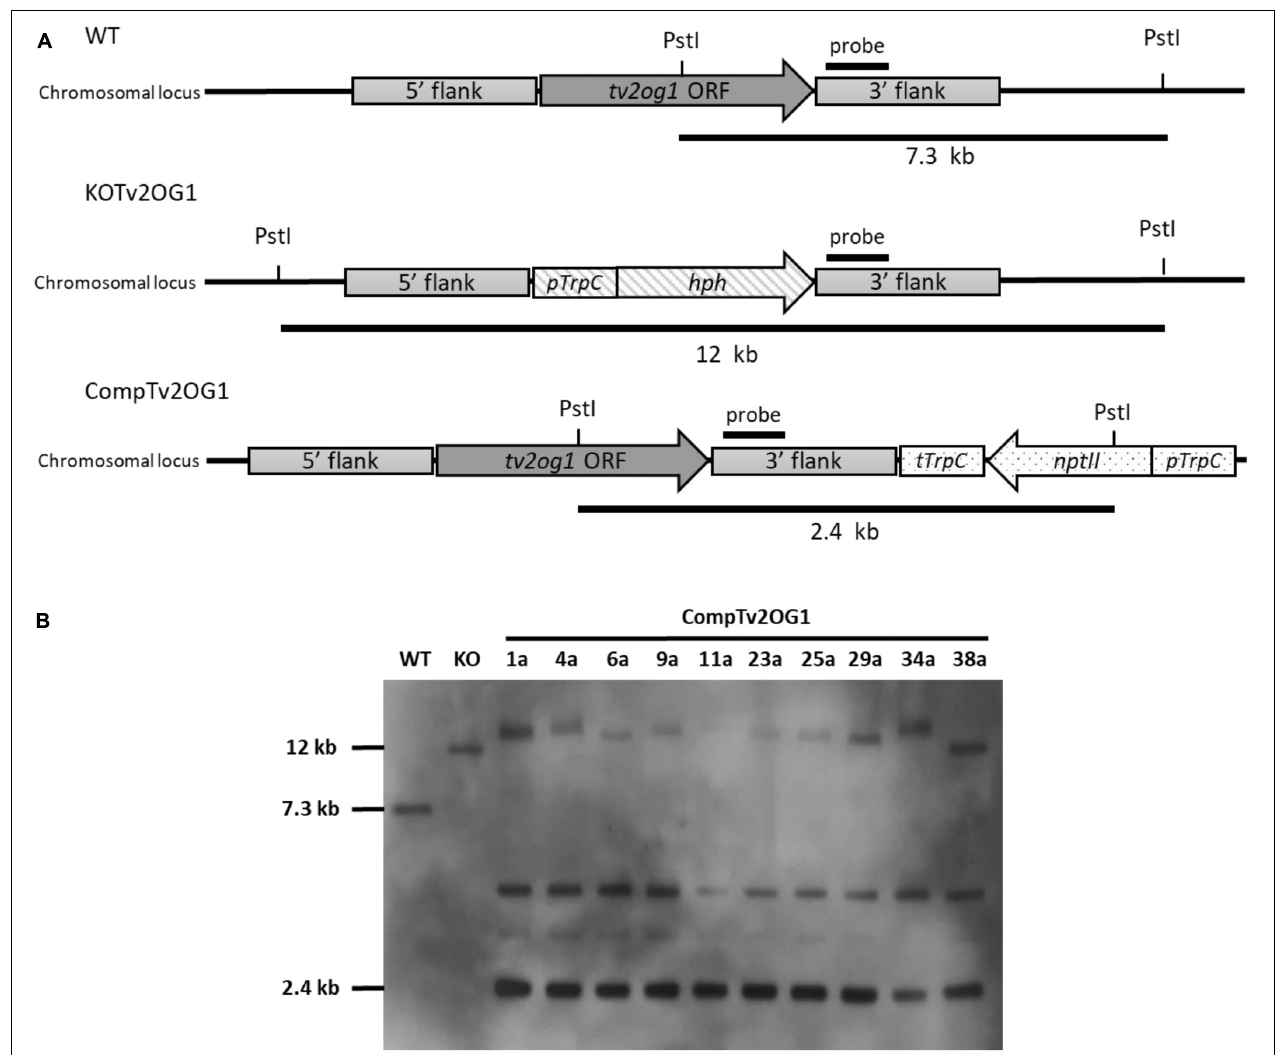
FIGURE 4 | Southern blot confirmation of complementing mutants of the tv2og1 gene in T. virens . (A) Schematic representation of the gene deletion and complementation strategy. For gene deletion, tv2og1 was replaced by the homologous integration of the pTrpC/hph fragment (1.4 kb) that confers resistance to hygromycin B. For gene complementation, the (cid:49) tv2og1 null mutant was transformed with the complementing construct created using the TrichoGate system. The complementing region containing a 1.5 kb promoter and 0.5 kb terminator fragments, along with the tv2og1 ORF, was fused to the neomycin phosphotransferase encoding gene ( nptII ) (conferring resistance to geneticin G-418) under control of the tryptophan gene promoter ( pTrpC ) and tryptophan gene terminator ( tTrpC ). (B) Southern blot of the T. virens WT and the tv2og1 deletion and complementing mutants was carried out using a fragment of tv2og1 terminator as a probe. The blot shows the 2.4 kb fragment size expected in T. virens WT strain, the 12 kb fragment size expected for the T. virens tv2og1 null mutant strain and the 2.5 kb fragment expected in T. virens Ctv2og1 strains when gDNA was digested with Pst I. An extra band was present in all ten complementing mutants suggesting ectopic integrations of the GtR cassette in the T. virens